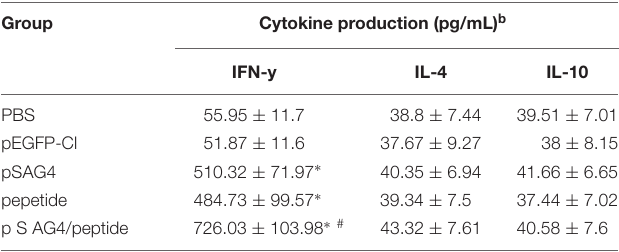
TABLE 3 | Cytokine production by splenocyte a cultures from immunized BALB/c mice. Group